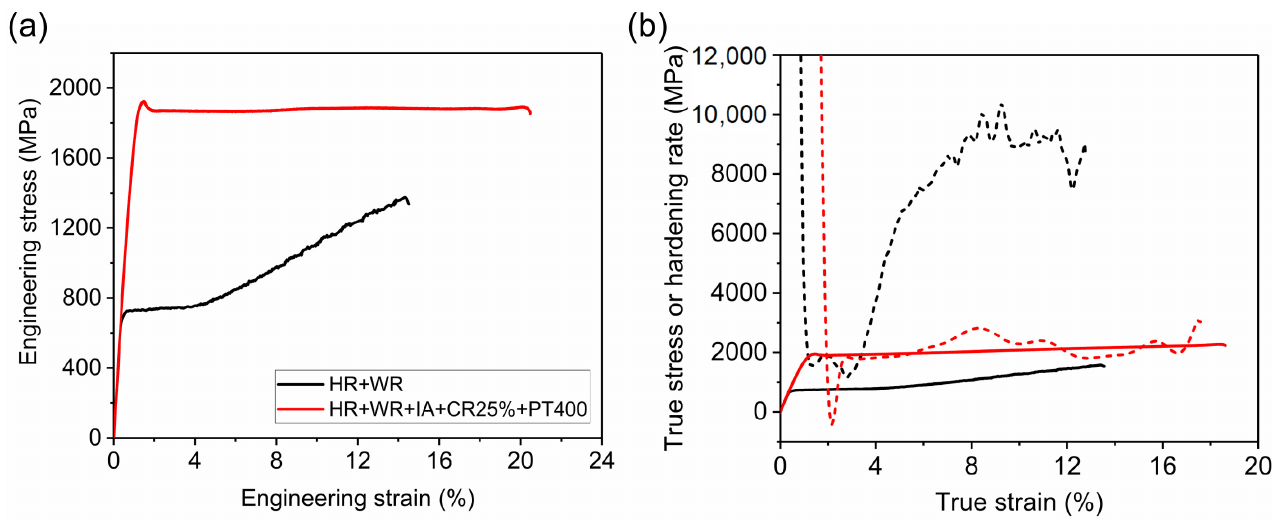
Figure 6. ( a ) Engineering stress–strain curves of HR + WR sample and HR + WR + IA + CR25% + PT400 sample. ( b ) The corresponding true stress–strain curves (solid line) and the work hardening rate curves (dotted line).